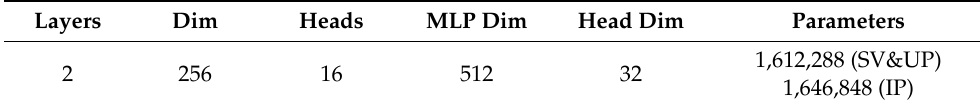
Table 1. The parameters of our